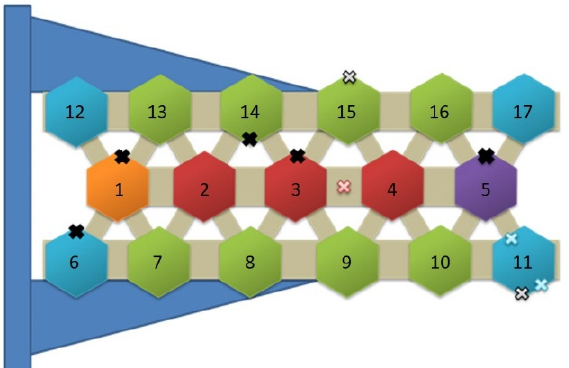
Figure 5. Pump scheme showing all 17 cartridges grouped in five master-slave sections (light blue = corner, green = outer edge, red = innermost, orange = inner edge, purple = inner edge but with a different heater design for testing purposes). The crosses represent the thermocouples for the temperature reading, the cartridge numbering is relevant for Section 7.